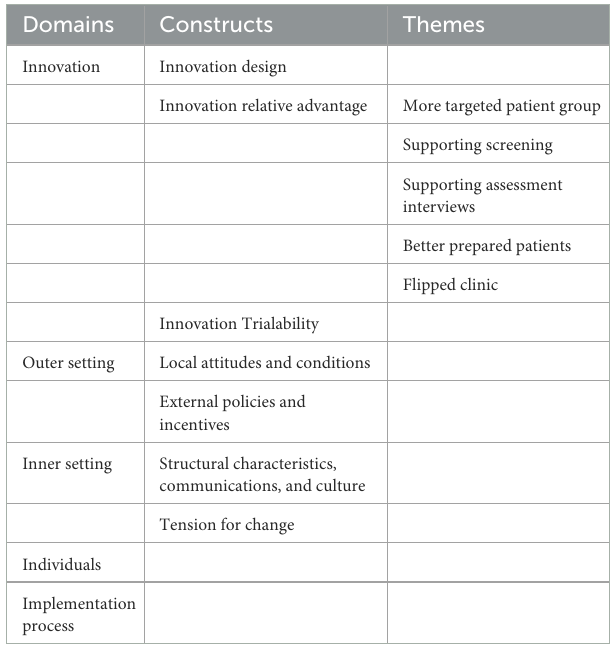
TABLE 3 Analyzed domains, constructs, and